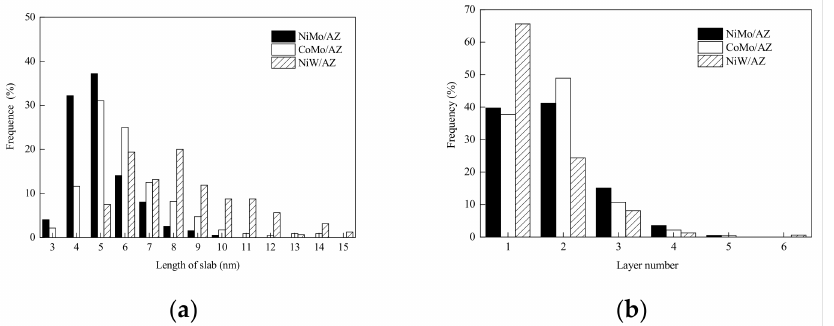
Figure 4. The properties of the slabs over the sulfided catalysts. ( a ) Length of Mo/WS 2 slabs; ( b ) Number of layers of the